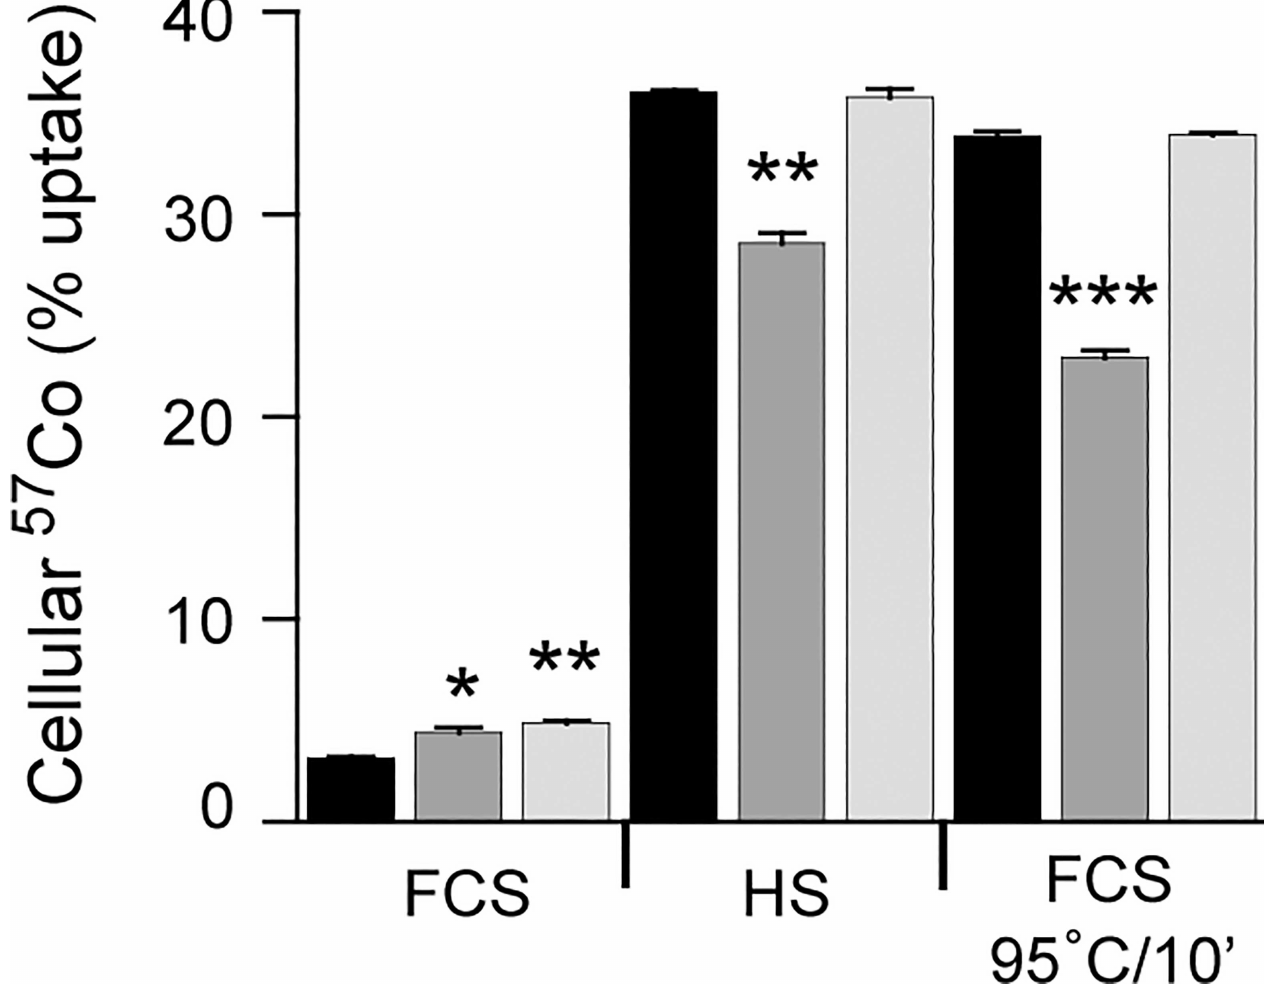
Fig 6. Assessment of HT1080 cellular 57 Co-Cbl uptake in the presence of anti-transcobalamin antibody or anti-haptocorrin antibody. HT1080 cells were cultured in DMEM containingeither 10% FCS, 10% heat-treated(95˚C for 10 min) FCS, or 10% HS, for 48 h in either the absenceof antibody(black bars) or the presenceof anti-transcobalaminantibody (dark grey bars) or the presence of anti-haptocorrin antibody (light grey bars). The cells were harvestedfor 57 Co analysisafter 48 h. Data are mean values + SE (n = 3). * p < 0.05, ** p < 0.01, *** p <